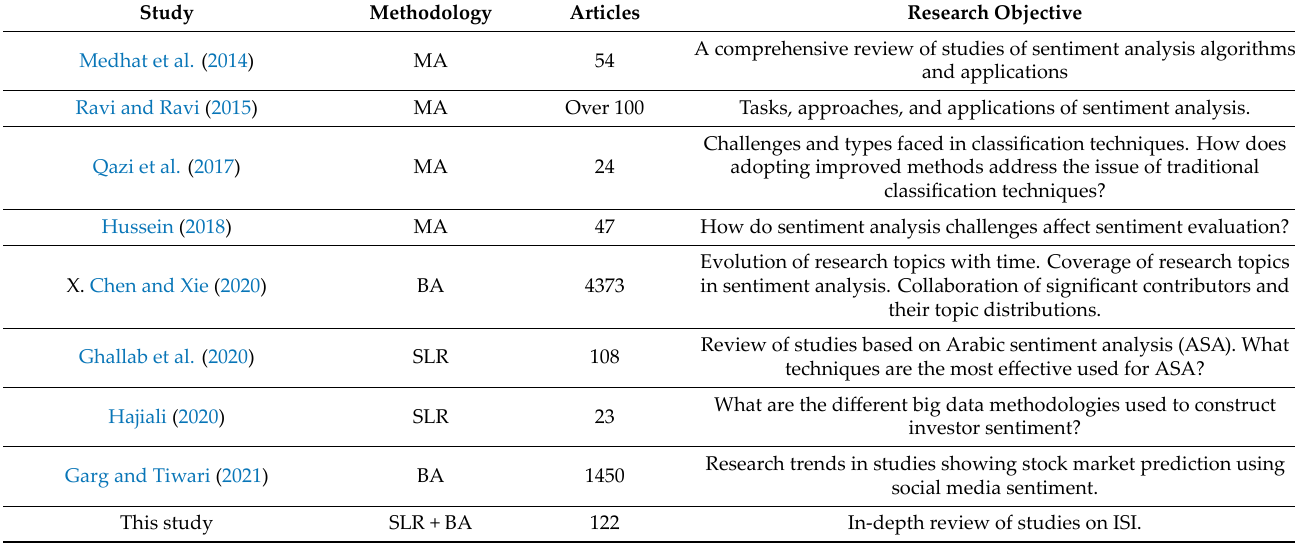
Table 1. Summary of the recent reviews on sentiment